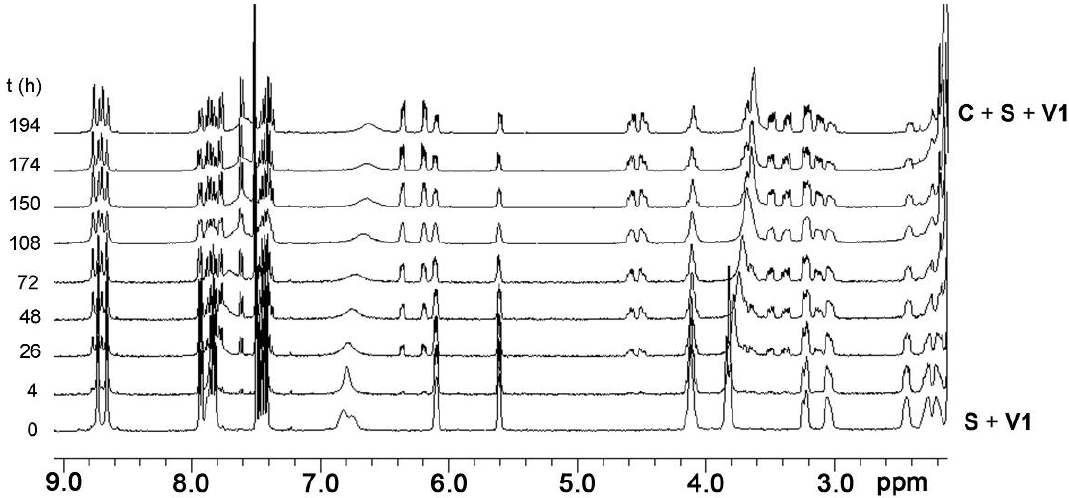
/CD CN 1:1 ( v / v 3 3